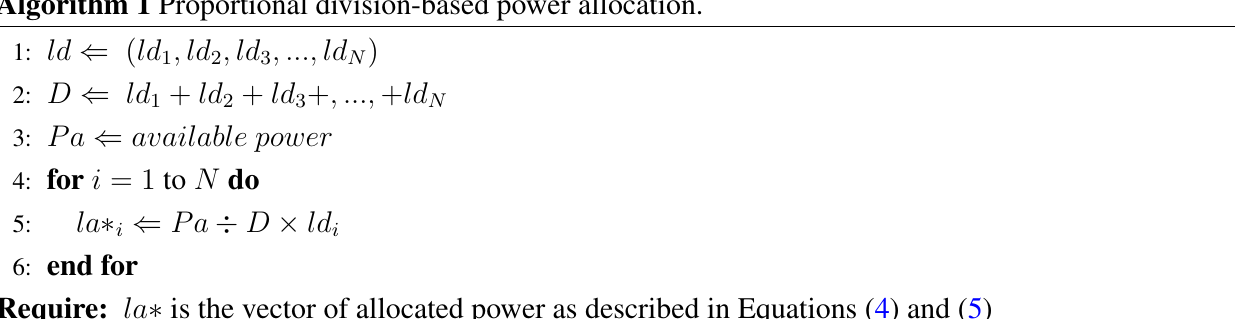
Algorithm 2. The microgrid operator can choose one of them as a fair division function. Algorithm 1 Proportional division-based power